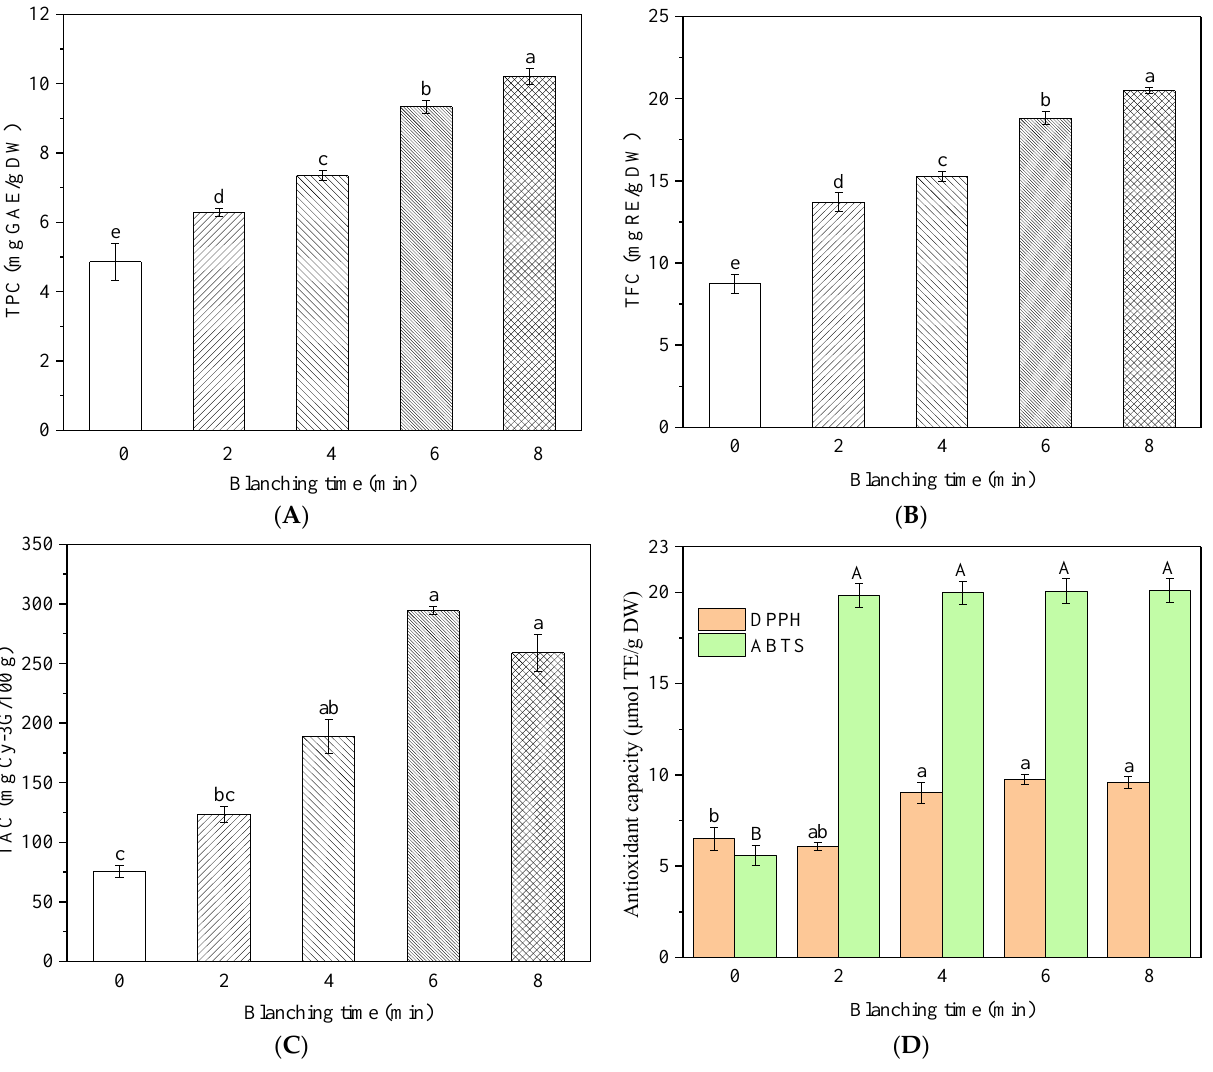
Figure 7. Changes in the total polyphenol content (TPC) ( A ), total flavonoid content (TFC) ( B ), total anthocyanin content (TAC) ( C ), and antioxidant capacity ( D ) of A. sessiliflorus fruits with different blanching treatments. Different letters indicate significant differences ( p < 0.05) according to the Duncan test.